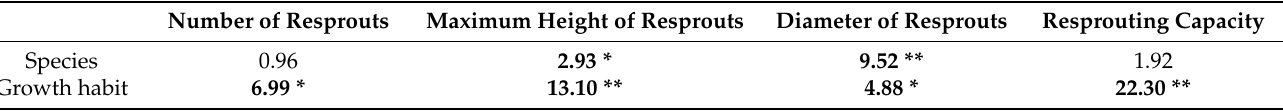
Table 4. Results of ANOVA on the number of resprouts, maximum height of resprouts, diameter of resprouts, and resprouting capacity. The explanatory variables were in all cases species and growth habit. Values indicate the F-values and stars indicate the significance level. Significance levels: ** <0.01; * <0.05; <0.1.